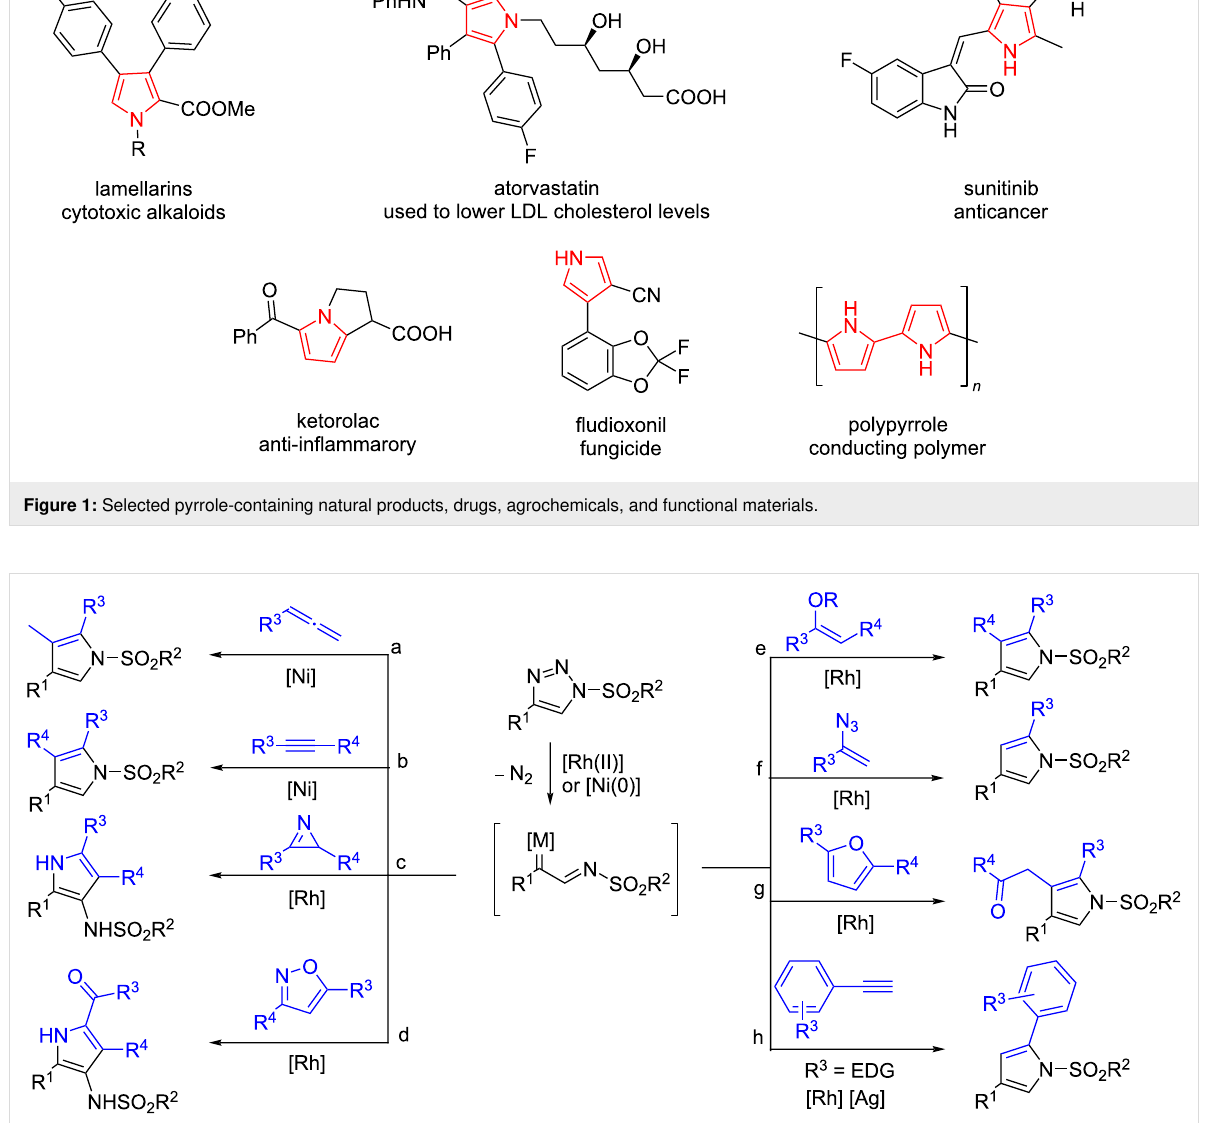
pyrrolones, imidazolones, oxazoles, azepines [19-22], and pyrroles